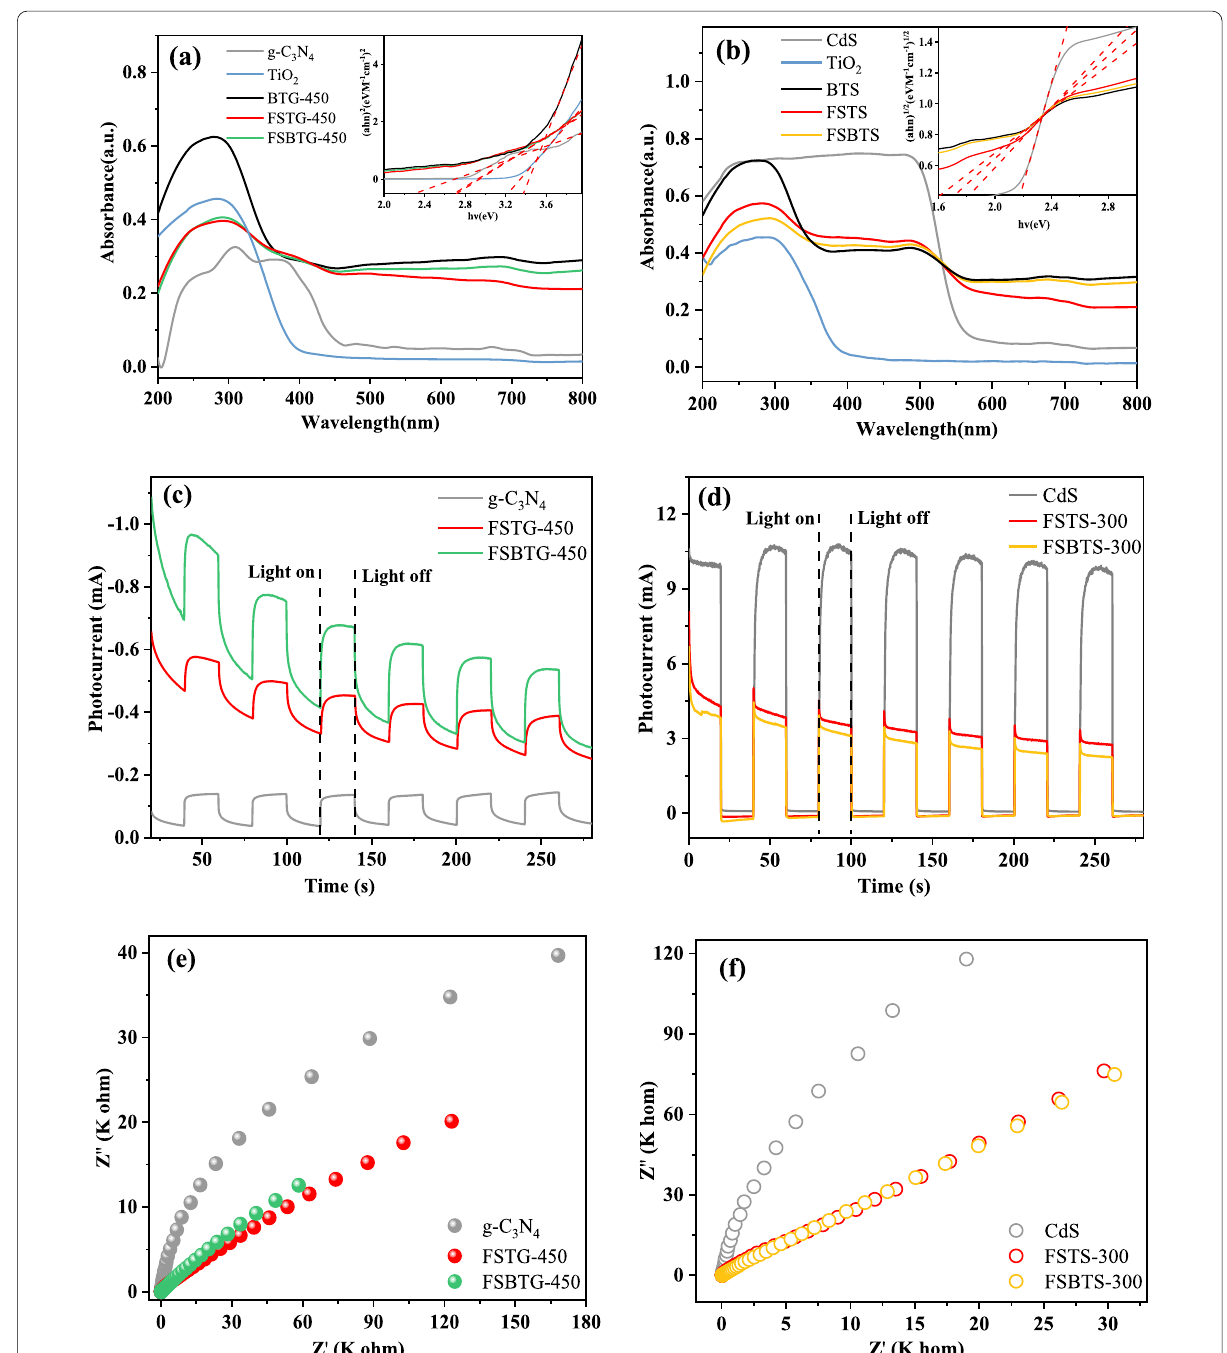
Fig. 3 UV–vis/DRS spectra, Tauc plots, Transient photocurrent response and EIS spectra of g-C 3 N 4 -based photocatalysts ( a , c , e ) and CdS-based photocatalysts ( b , d , f ) under visible light illumination (> 420